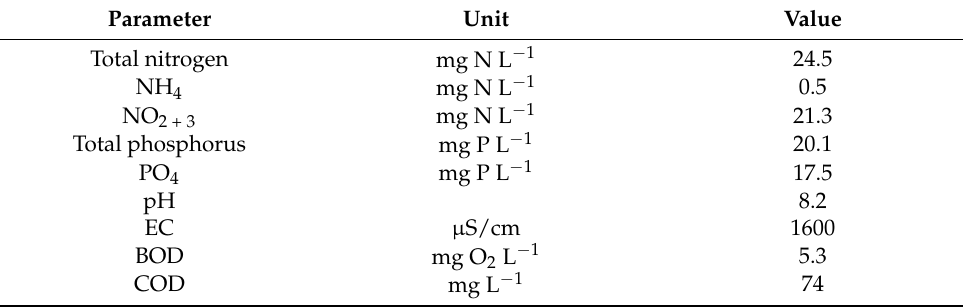
Table 1. Characteristics of wastewater used for the